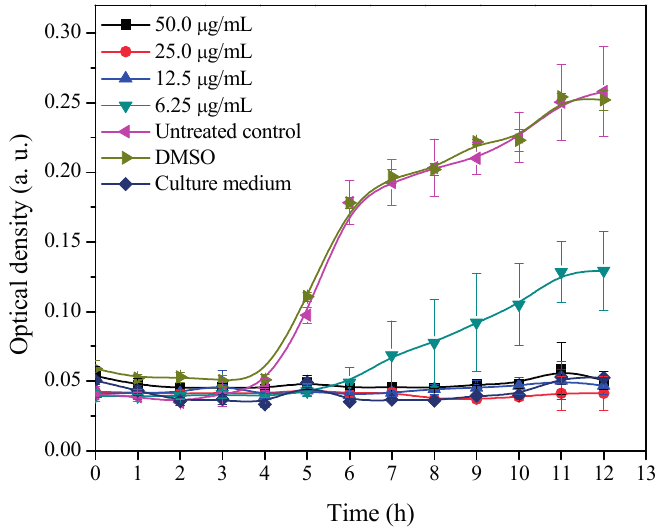
Figure 2. Bacterial growth-inhibitory concentration curve of 3 ′ -demethoxy-6- O - demethylisoguaiacin against MRSA.